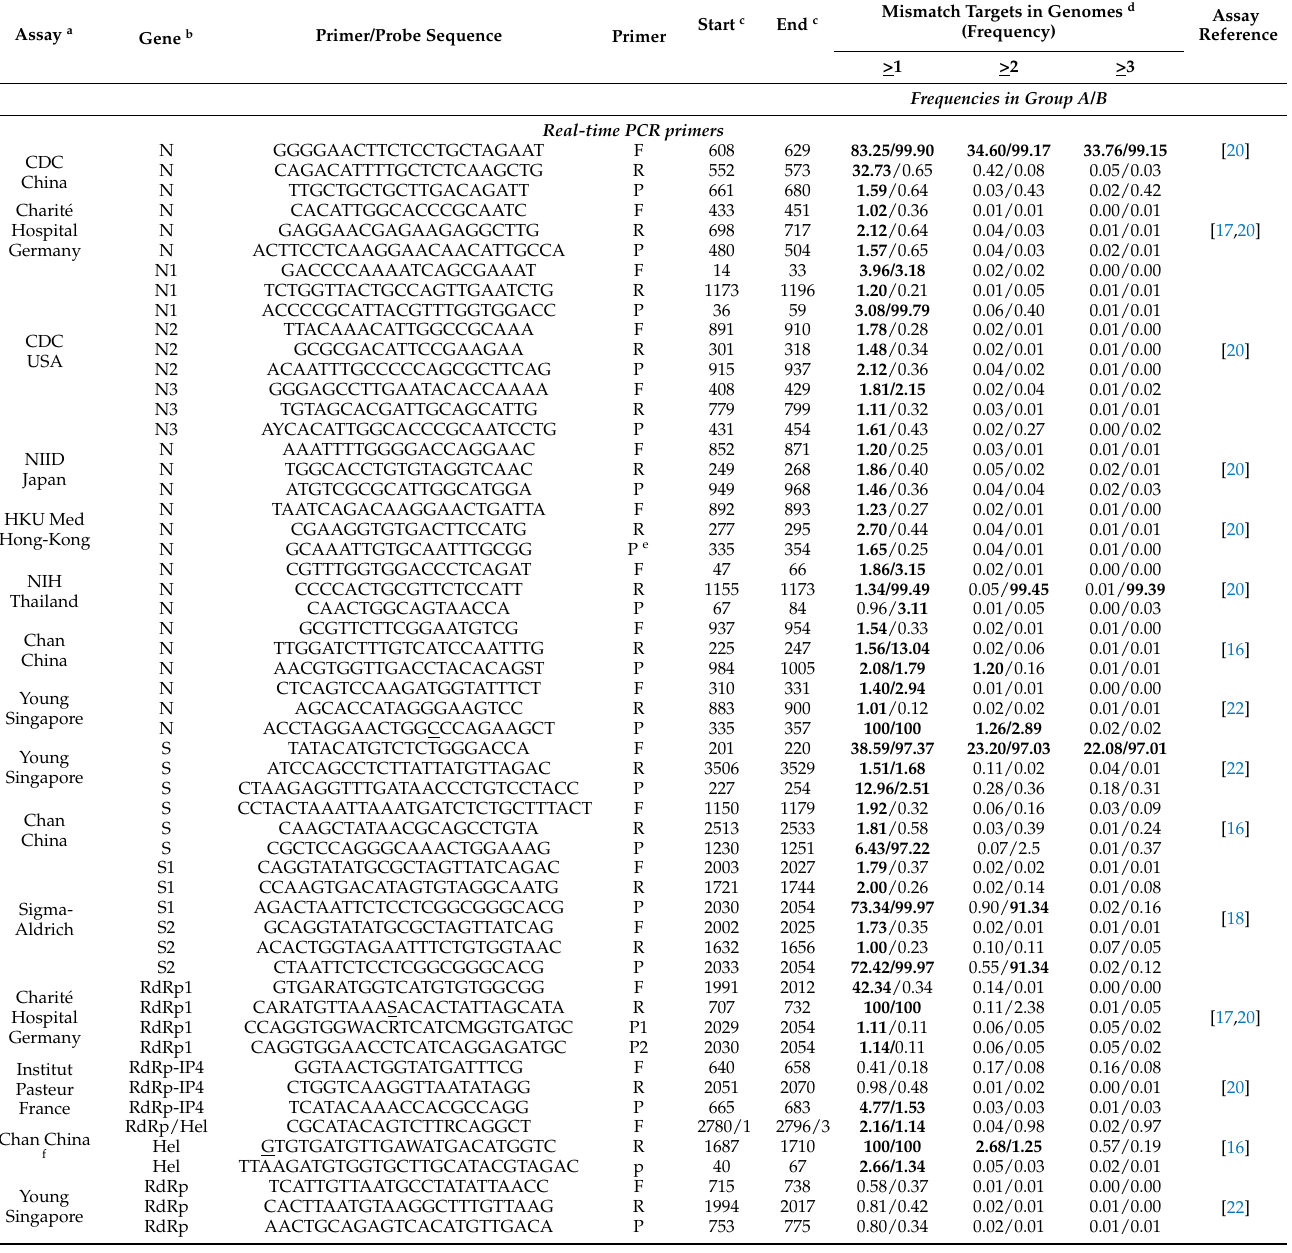
Table 1. Summary of primers and probes mismatches of RT-PCR, Qualitative PCR, and Sequencing assays posted by WHO and published by original articles for detection of